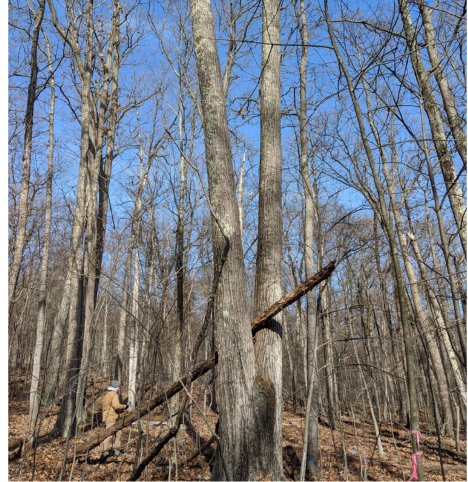
Figure 17. Fork above DBH resulting in two detections but cataloged as one tree per the field data collection